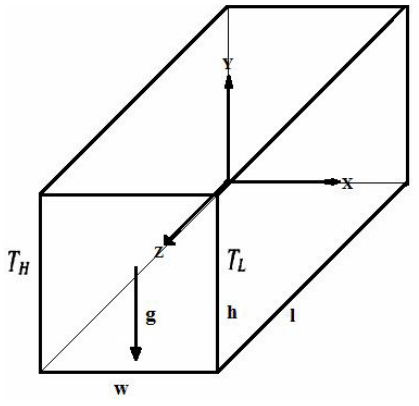
Fig. 1. schematic of 3-D